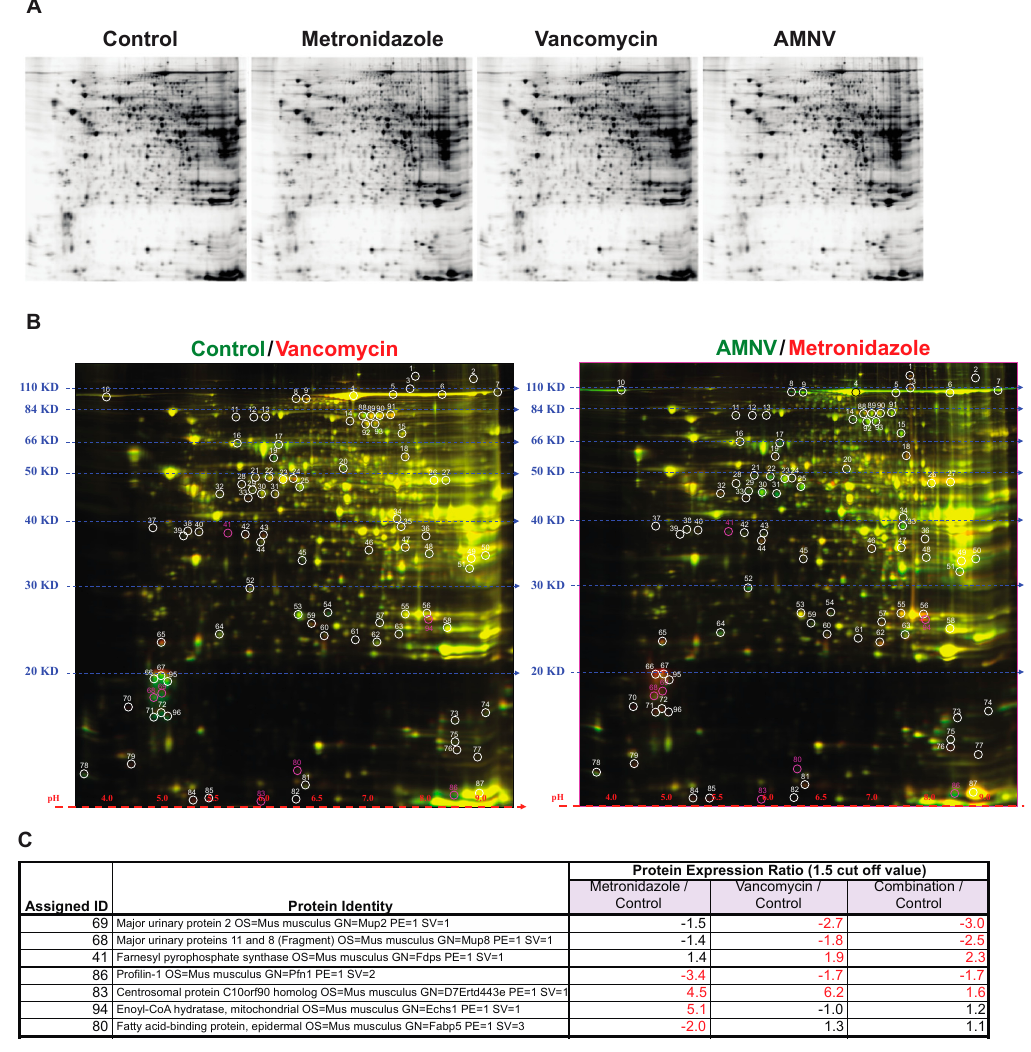
Figure 4. Gel electrophoresis analysis of protein lysates from livers of mice in the different antibiotic treatment groups. ( A ) Proteins were separated by sodium dodecyl sulfate polyacrylamide gel electrophoresis (SDS-PAGE) according to molecular weight and isoelectric charge. ( B ) On the right, two-dimensional fluorescence difference gel electrophoresis (2D-DIGE) image of control lysate proteins labeled with Cy-3 (green) and vancomycin lysate protein labeled with Cy-5 (red), and on the left, image of AMNV lysate proteins labeled with Cy-3 (green) and metronidazole lysate proteins labeled with Cy-5 (red). Molecular weight and isoelectric points are indicated on the left and bottom of the image, respectively. Spots in red or green represent proteins with increased expression in vancomycin and metronidazole, and control and AMNV lysates, respectively, while the yellow spots represent proteins with similar expression in the livers of control and vancomycin or AMNV and metroniazole treated mice. Differentially expressed spots are circled and assigned a number for the ease of identification. Fold change of protein expression was determined by DeCyder analysis and the selected spots highlighted in pink were identified by mass spectrometry. ( C ) List of assigned protein IDs identified by mass spectrometry and their relative expression ratio (treated vs control). A larger than 1.5 times change in expression was considered to be significant (indicated by fold change in red). See Supplementary Table S2 for the list of all protein spots.